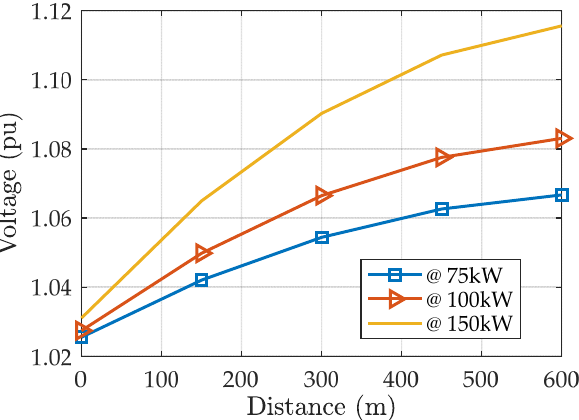
Figure 7. Voltage pro fi le at di ff erent generated power levels before applying any control.